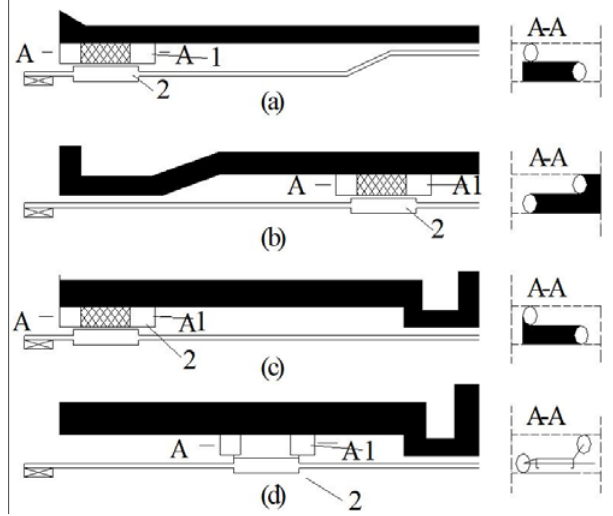
Figure 5. Motion characteristics of the shearer: ( a ) the shearer is at the end of the working face, the left drum is on the top, the right drum is at the bottom, and the scraper conveyor is in a bent state; ( b ) the shearer is inclined-sumping coal cutting, the left drum is at the bottom, the right drum is on the top, and the scraper conveyor is in a straight state; ( c ) the shearer returns to the end of the working face, the left drum is on the top, the right drum is at the bottom, and the scraper conveyor is in a straight state; ( d ) the shearer keeps cutting coal and runs towards the other end of the working face, the left drum is at the bottom, the right drum is on the top.